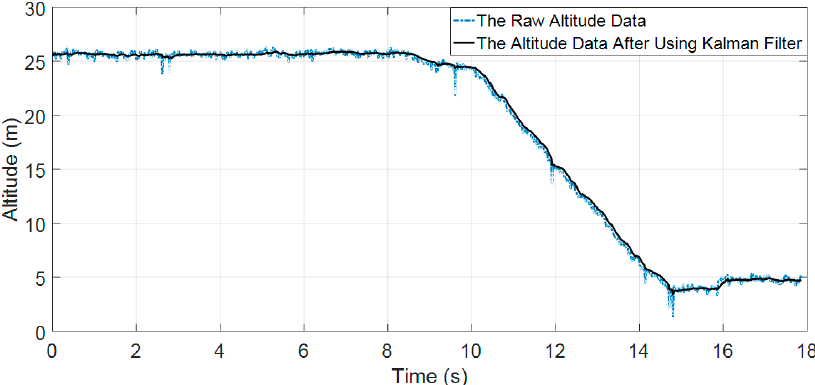
Figure 3. The comparison between the raw altitude signal and the altitude signal with the use of the simple Kalman